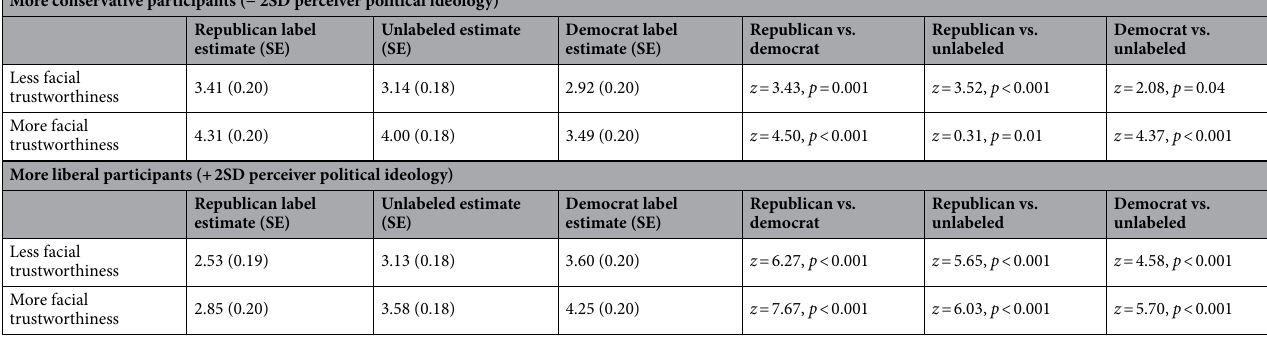
Table 4. Comparisons of evaluated liability of partisan groups by political ideology (+ /– 2SD) and facial trustworthiness (+ /− 1SD) in experiment